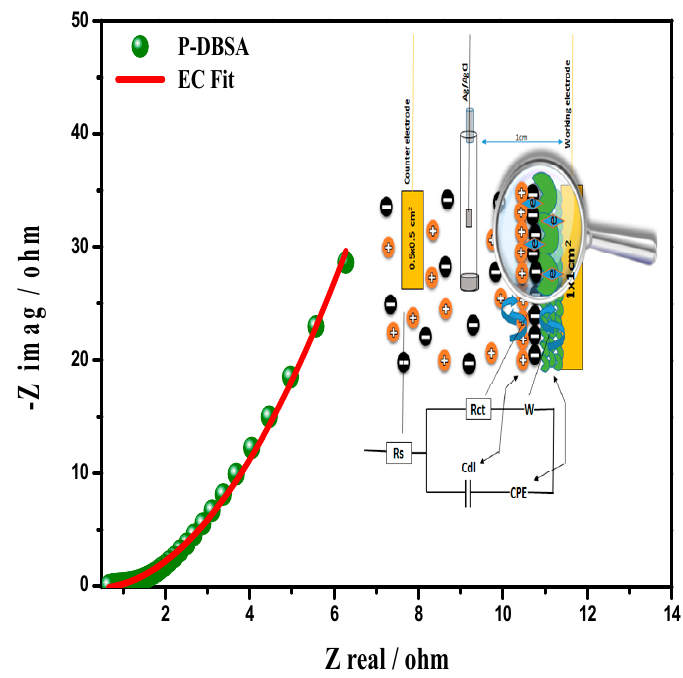
Figure 7. Nyquist plot of the PANI–DBSA and the best-fitted equivalent circuit with mechanisms for elemental assignment.